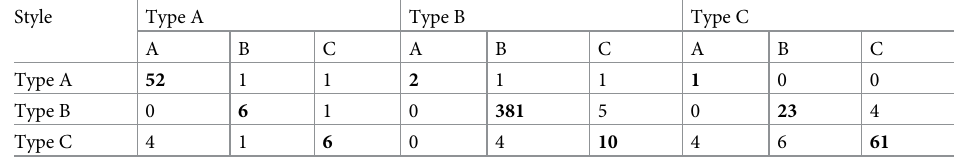
Table 3. Comparison of results of linear discriminant and random forest analyses for Louisiana Waterthrush song types. For birds classified as Type A (left third of panel), 52 individuals were classified as Type A by both analy- ses, 6 individuals each as Types B and C by both analyses, and fewer individuals were assigned different song types by each analysis (those numbers off the diagonal). This is repeated in the middle and right panels for individuals classified as Types B and C. The numbers away from those in bold on the diagonal in each panel represent the inconsistent classi- fications between the two methods.